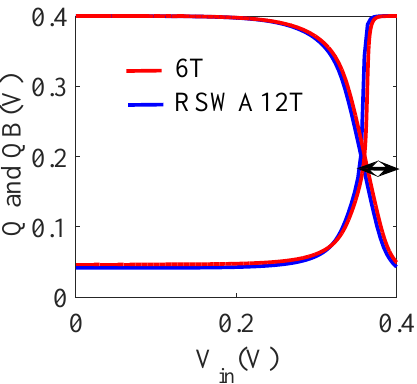
Figure 6. Comparison of WLWM with conventional 6TSRAM